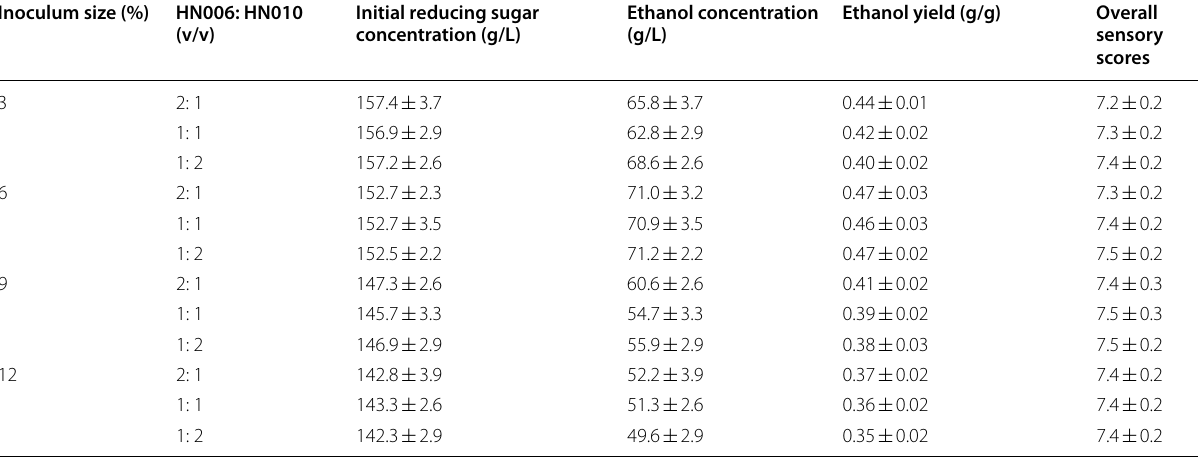
Table 4 Effect of different inoculum sizes and ratios of strain HN006 and strain HN010 on production of Chinese chestnut wine after 6 days of co-culture fermentation Inoculum size (%)